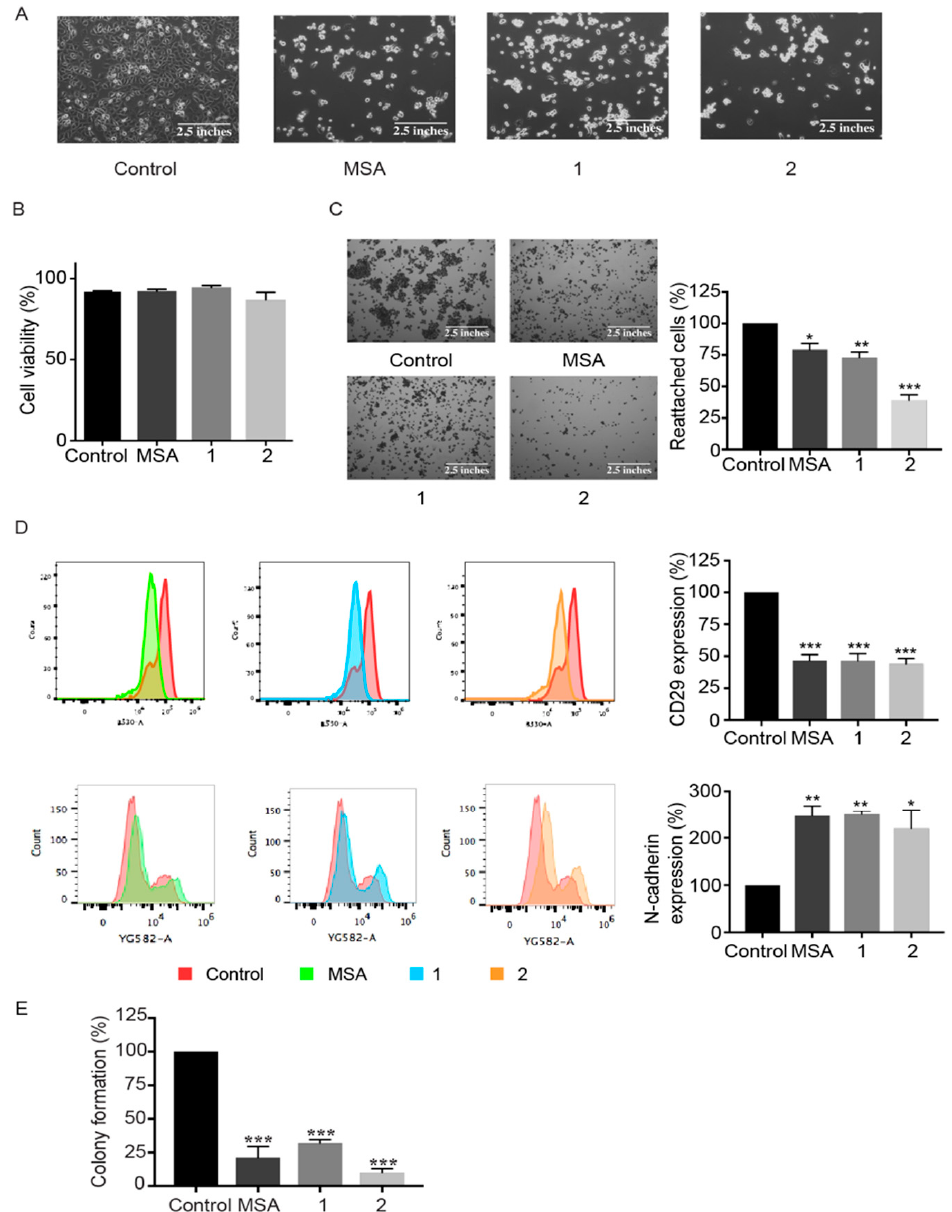
Figure 3. Compounds 1 and 2 and MSA induce loss of cellular adhesion prior to cell death and impair the colony forming ability. Panc-1 cells were treated with 5 µM of MSA, or compounds 1 or 2 for 24 h. ( A ) Representative phase-contrast images of treatment-induced cell detachment with respective compounds. ( B ) The viability of the floating cells was assessed using a trypan blue exclusion assay. ( C ) Adhesion assay. After 24 h of treatment with respective compounds, the non-adherent but viable cells, were collected and an adhesion assay was performed for 3 h, following which the adherent cells were stained with Coomassie Brilliant Blue. Representative phase-contrast microscopic images and graphical representation of percentage of non-adherent cells reattaching the tissue culture treated plates. Error bars indicate mean ± SEM of three biological replicates. ( D ) The expression levels of adhesion proteins, CD29, and N-Cadherin, post 24 h treatment with respective compounds as analyzed by flow cytometry and its graphical representation. Error bars indicate mean ± SEM of three biological replicates. ( E ) Clonogenic assay. Post 24 h treatment, with respective compounds, the non-adherent cells were collected and re-seeded in 24 well plates to check for the colony forming ability of these cells. Reduced colony forming ability indicates cell death. Error bars indicate mean ± SEM of three biological replicates. Statistical significance as compared to control * p < 0.05, ** p < 0.01, *** p < 0.001.